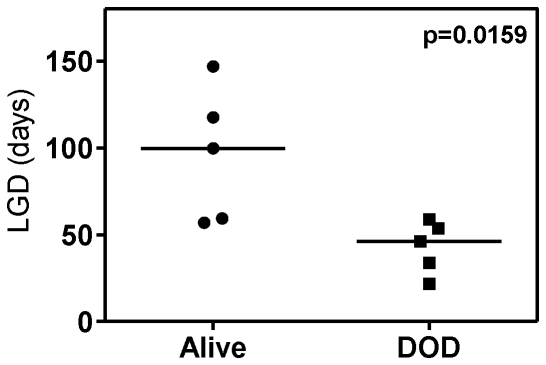
LGD in response to VXL treatment in xenografts stratifies according to patient outcome.Median LGD obtained by VXL treatment for a panel of ALL xenografts derived from long term survivors (Alive) and from patients who died of their disease (DOD). There is evidence that the two groups are different (p = 0.0159) by Mann-Whitney two tailed test.